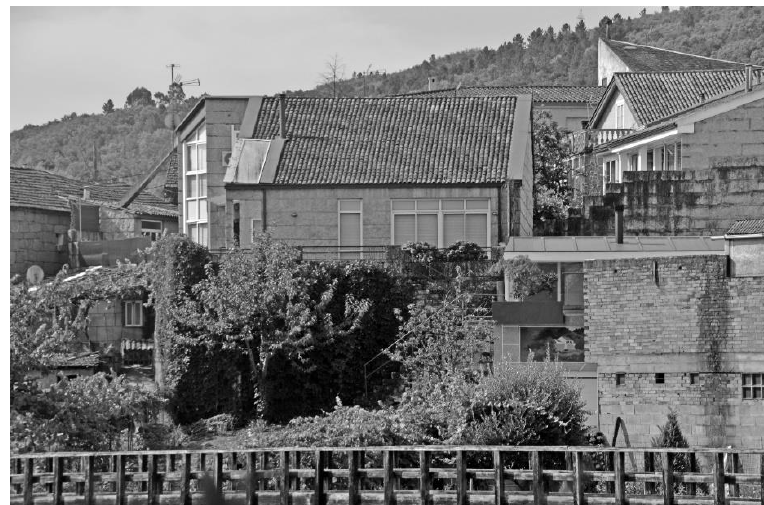
Figure 5. Alén House in Leiro (Ourense, 1981), by María Jesús Blanco Piñeiro. Photo credit: mccl Figure5. Al é n HouseinLeiro(Ourense,1981),byMar í aJes ú sBlancoPiñeiro. Photocredit: arquitectos.